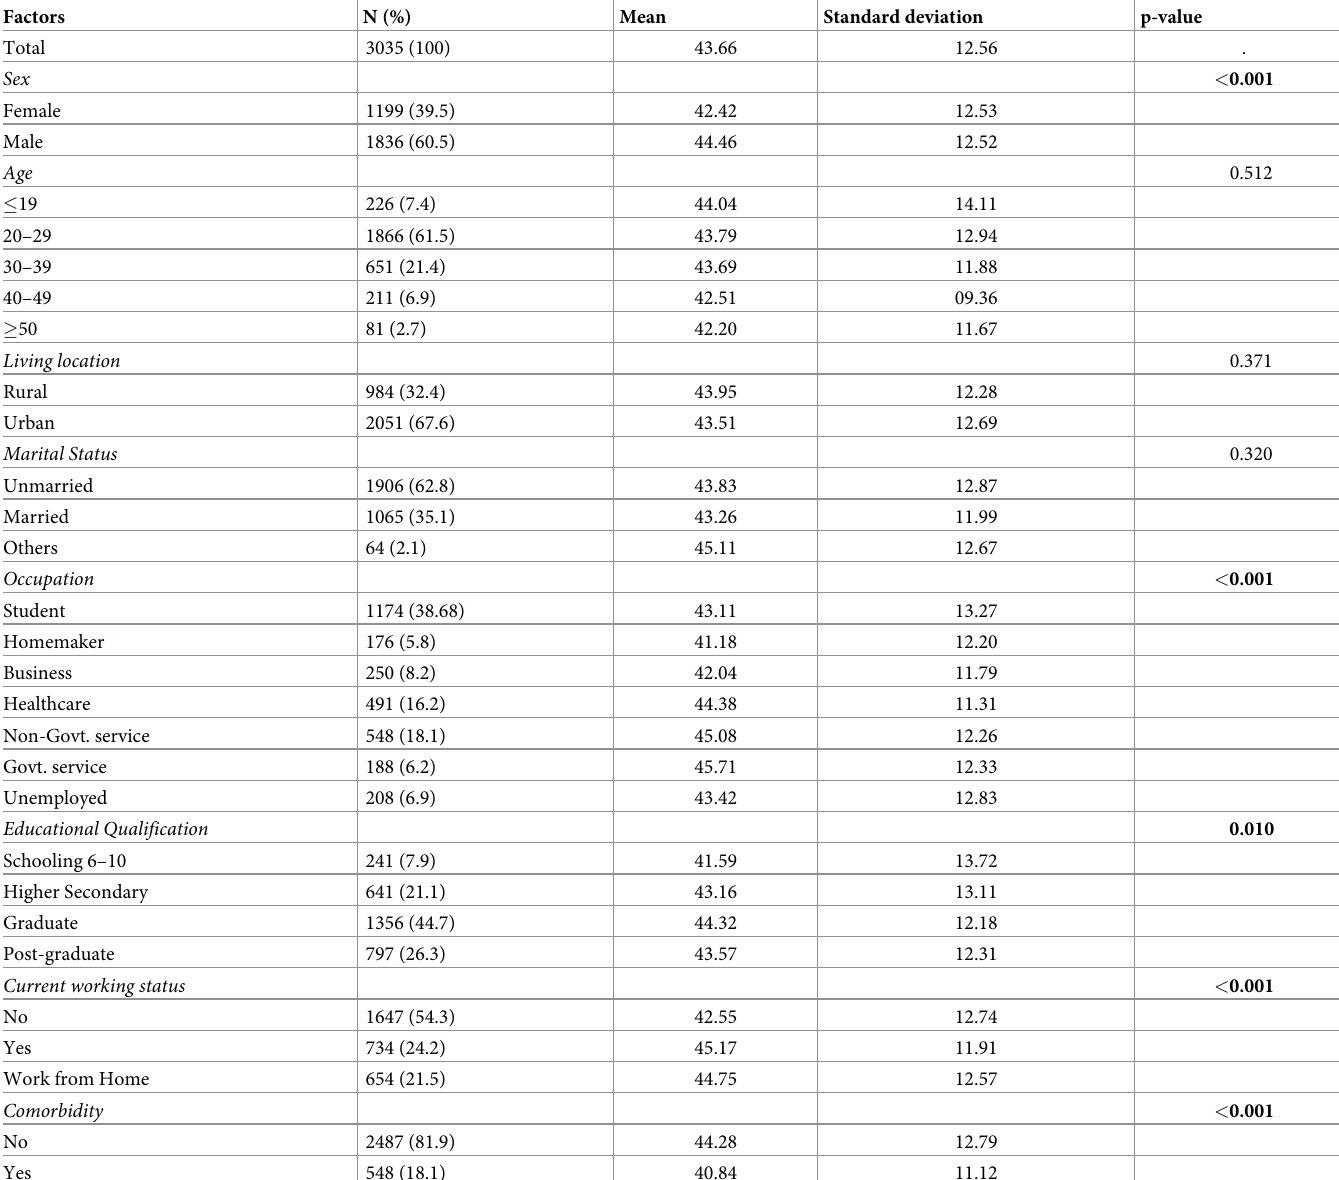
Table 1. Participants’ characteristics and association with the mental well-being